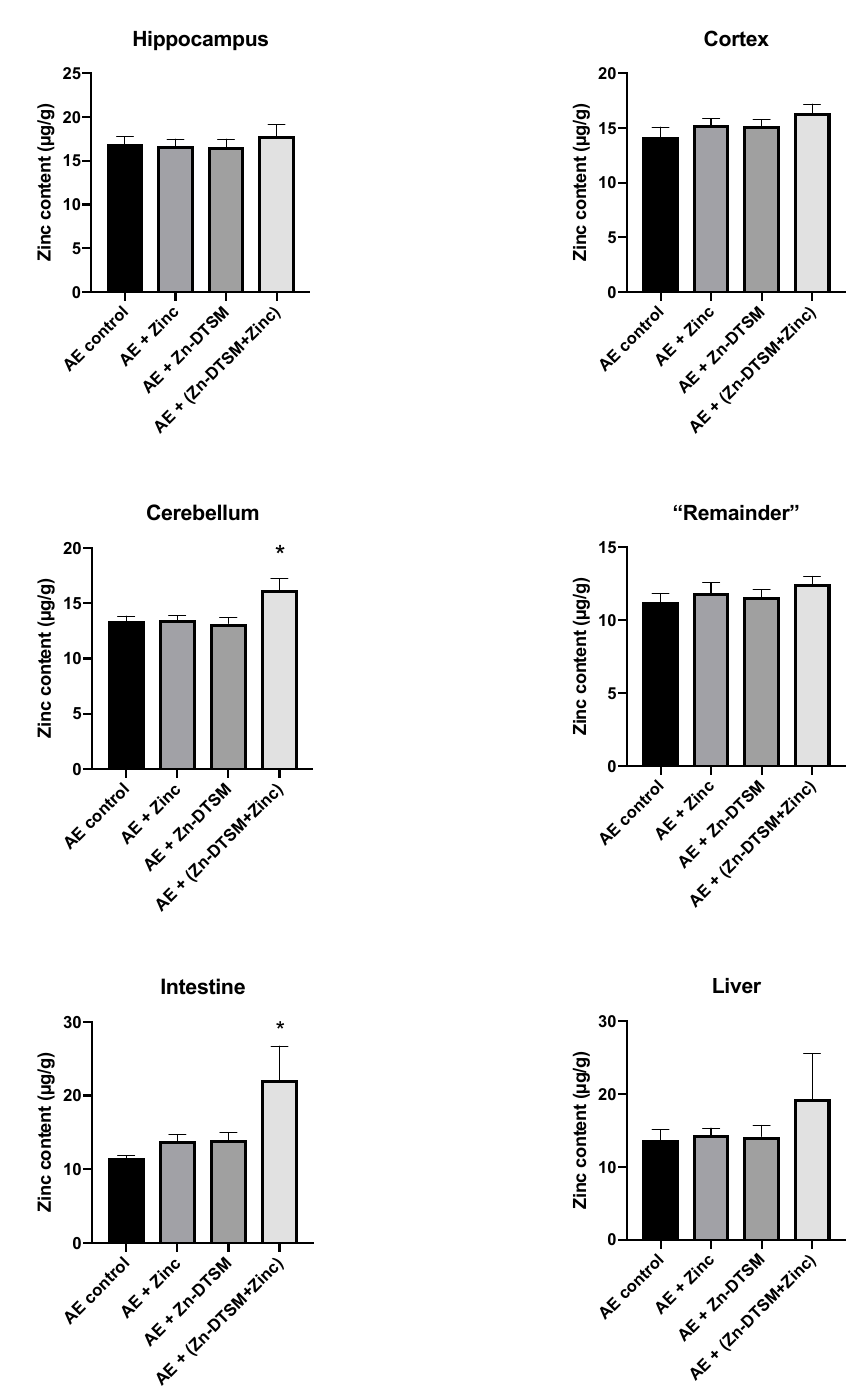
Figure 6. Zinc levels in various tissues harvested from 1.5-month-old acrodermatitis enteropathica (AE) mice treated with zinc diethyl bis(N4-methylthiosemicarbazone) (Zn-DTSM; 30 mg/kg/day). In the cerebellum there is a significant difference between the AE+(Drug+Zinc) group and all other groups ( p < 0.05). Similarly, in the intestine, the AE+(Drug+Zinc) group is significantly different to the AE control group only ( p < 0.05). Data are mean ± SEM. * p < 0.05.